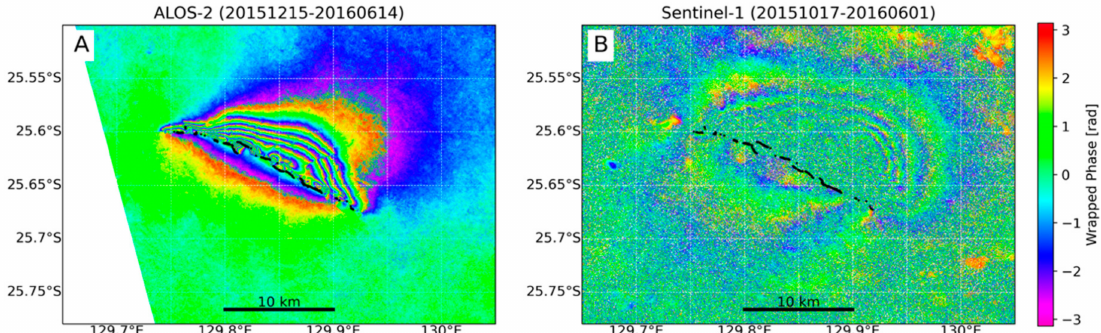
Figure 9. Wrapped phase co-seismic interferograms of the 2016 Petermann Ranges earthquake from ALOS-2 and Sentinel-1. ( A ) Ascending-pass, 182-day ALOS-2 L-band interferogram. ( B ) Descending-pass, 228-day Sentinel-1A C-band interfero- gram exhibits lower coherence. The dashed black line marks the mapped surface ruptures after